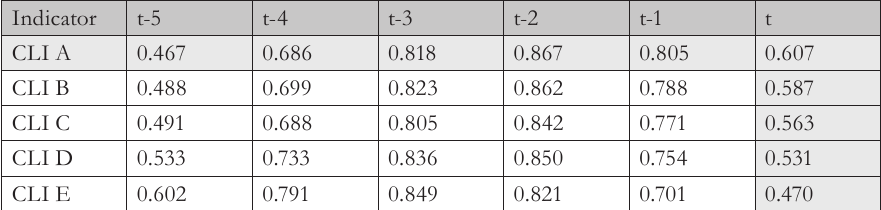
Tab. 5 – Cross-correlation results between CLI and GDP, different weights, 2000 – 2016.